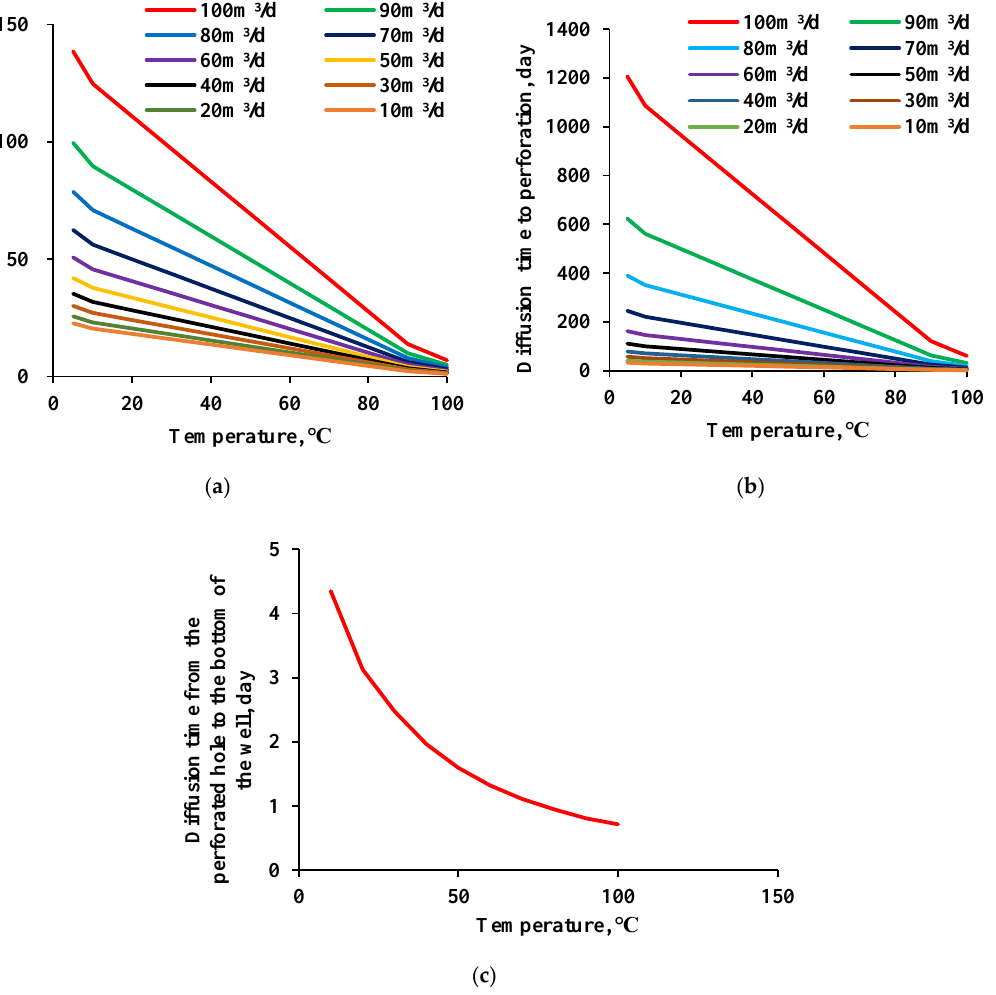
Figure 4. Diffusion time change of CO 2 in stratum under different conditions. ( a ) Variation of formation temperature and initial diffusion position under different daily water injections; ( b ) Variation of formation temperature and diffusion time to perforated hole under different daily water injection; ( c ) Diffusion time at different temperatures.